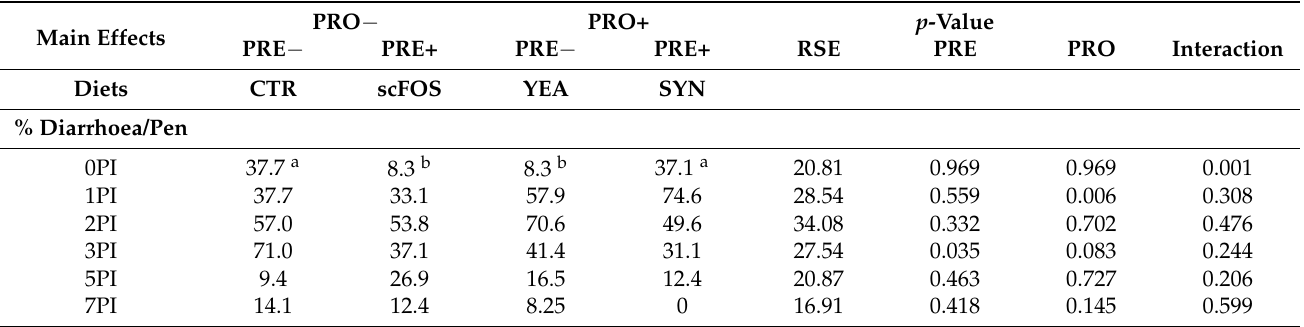
Table 3. Treatment effect on percentage of animals with diarrhea per pen measured at day 0, 1, 2, 3, 5, and 7 post inoculation. Considering diarrhea as a score ≥